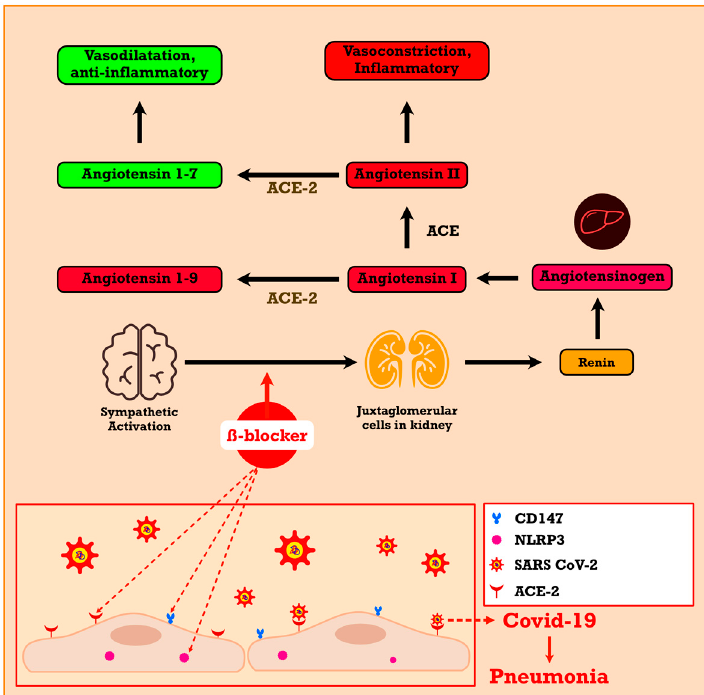
Figure 3. The effect of beta-blockers in the renin–angiotensin–aldosterone system. (Modified from [70]). CD147, cluster of differentiation 147; COVID-19, coronavirus disease 2019.